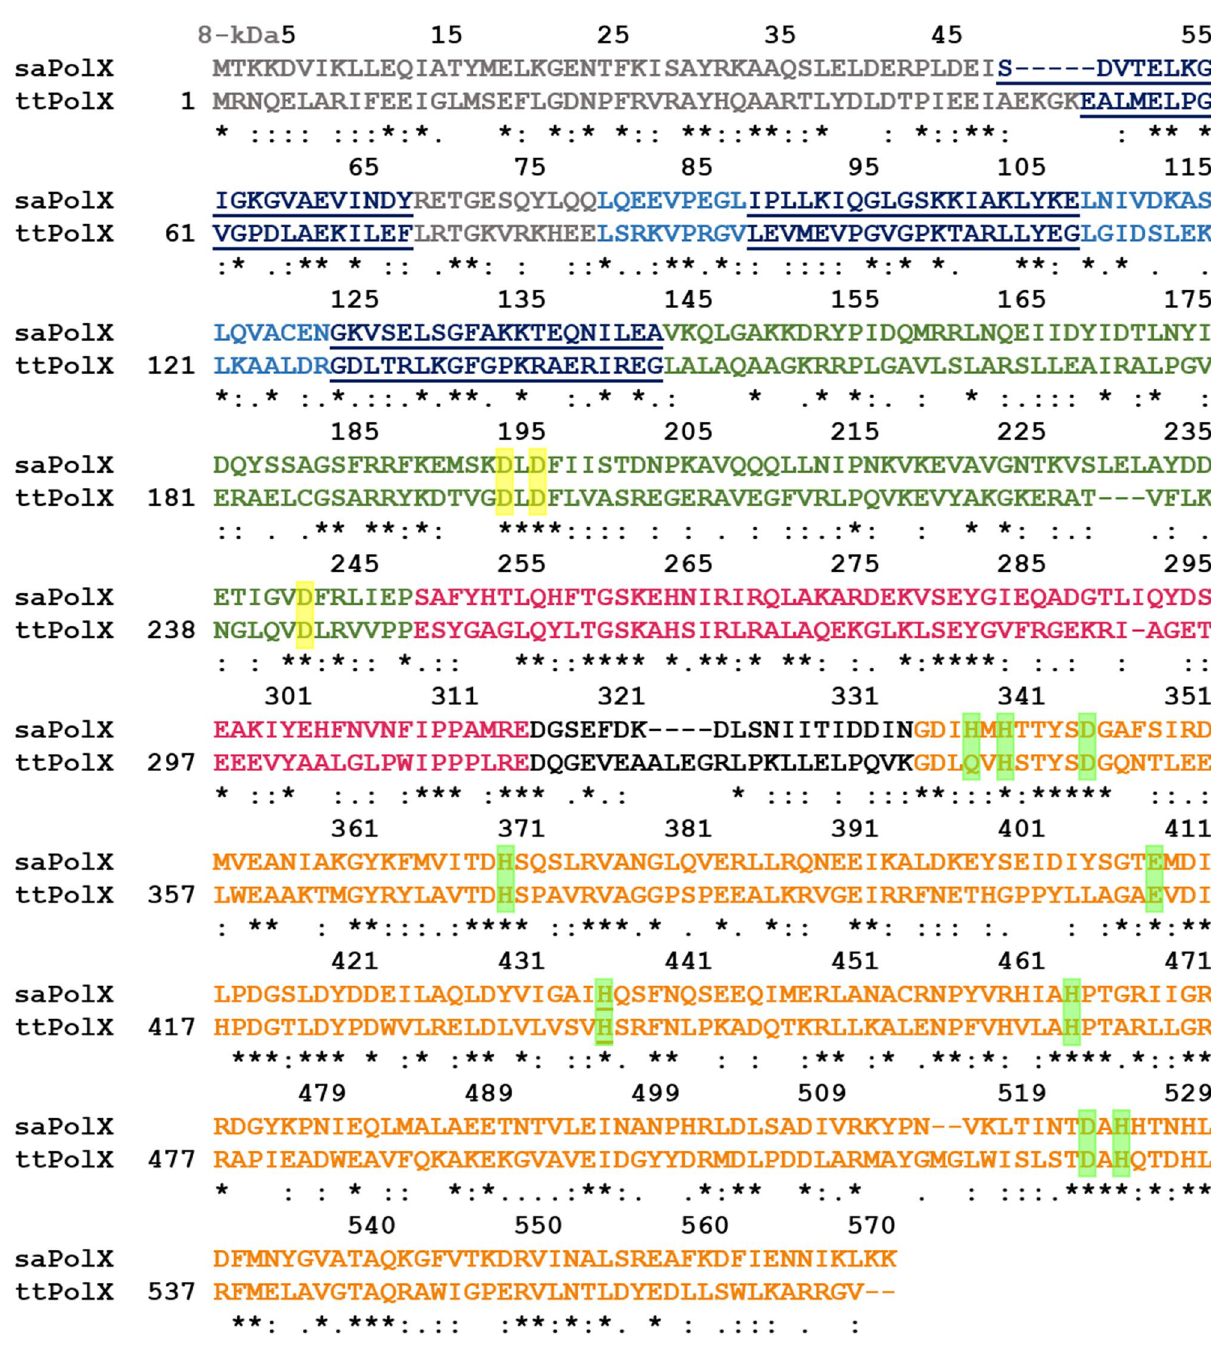
Figure 2. Sequence alignment of saPolX with ttPolX and homology model of saPolX. ( A ) The proteins encoded by genes SACOL1153 (saPolX) and TTHA1150 (ttPolX) from organisms S. aureus and T. thermophilus, respectively are aligned and compared. The residues in grey color represent the conserved 8-kDa domain, light blue color residues show fingers, green color shows palm, pink-colored residues show thumb and orange residues show PHP domain. The residues in three conserved HhH motifs are shown in dark blue color and underlined. The catalytic residues critical for DNA polymerase activity (including D193) of saPolX are highlighted by yellow boxes. The nine residues highlighted in green boxes indicate the residues, including H435 (underlined) that are critical for the exonuclease activity of ttPolX. ( B ) Homology model for saPolX. The homology model for saPolX was created using ttPolX binary structure as a template (PDB code: 3AU2) at the SWISS-MODEL server. The conserved 8-kDa, fingers, palm, thumb and PHP domains are displayed in grey, light blue, green, pink and orange color. The inset figure shows a close up of the PHP domain with the H435 displayed in stick representation and colored according to the atom. The H435 residue is known to be important for exonuclease activity and was selected for substitution with Ala (H435A) to prepare a mutant version that is incapable of exonuclease